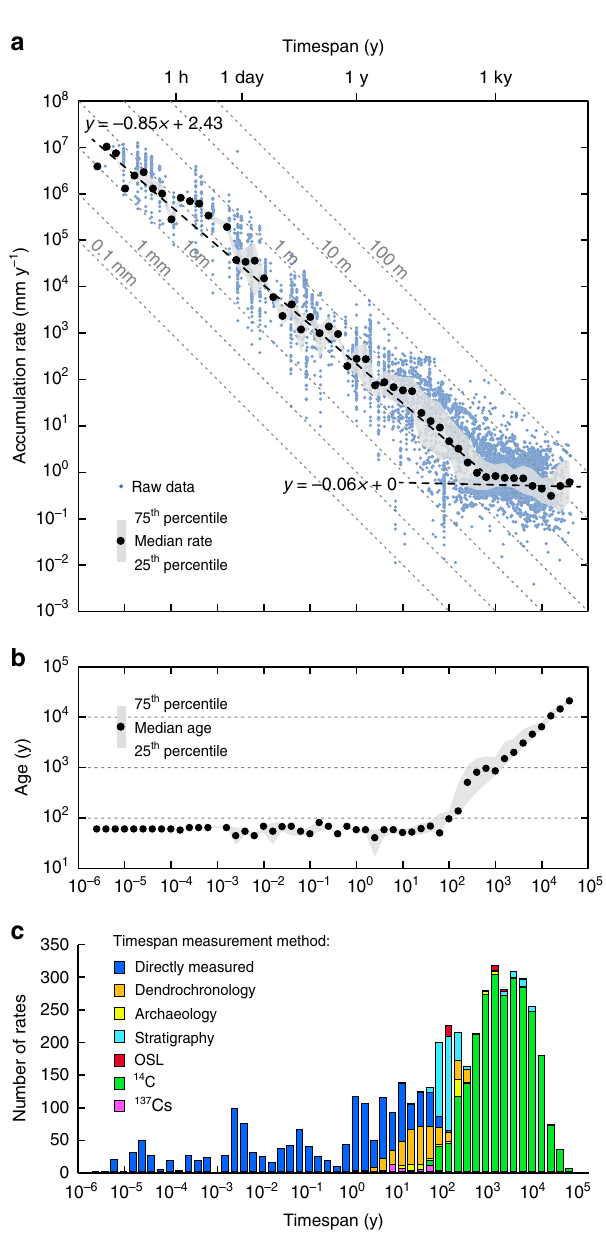
Fig. 3 Timespan and age dependence on alluvium accumulation rates. a Timespan versus rate plot for all data in the compilation (blue circles). Median rates (black circles) and associated 25 – 75th percentile range (gray shading) within 0.2 log timespan bins also shown. Gray dashed lines are contours of constant sediment thickness. b Timespan versus age plot. Median ages are shown as black circles, and associated 25 – 75th percentile range is marked by gray shading (0.2 log timespan bins). c Histogram showing data abundance in each 0.2 log timespan bin, and the range of timespan dating methods used for calculating rates. See Methods for information on these measurement